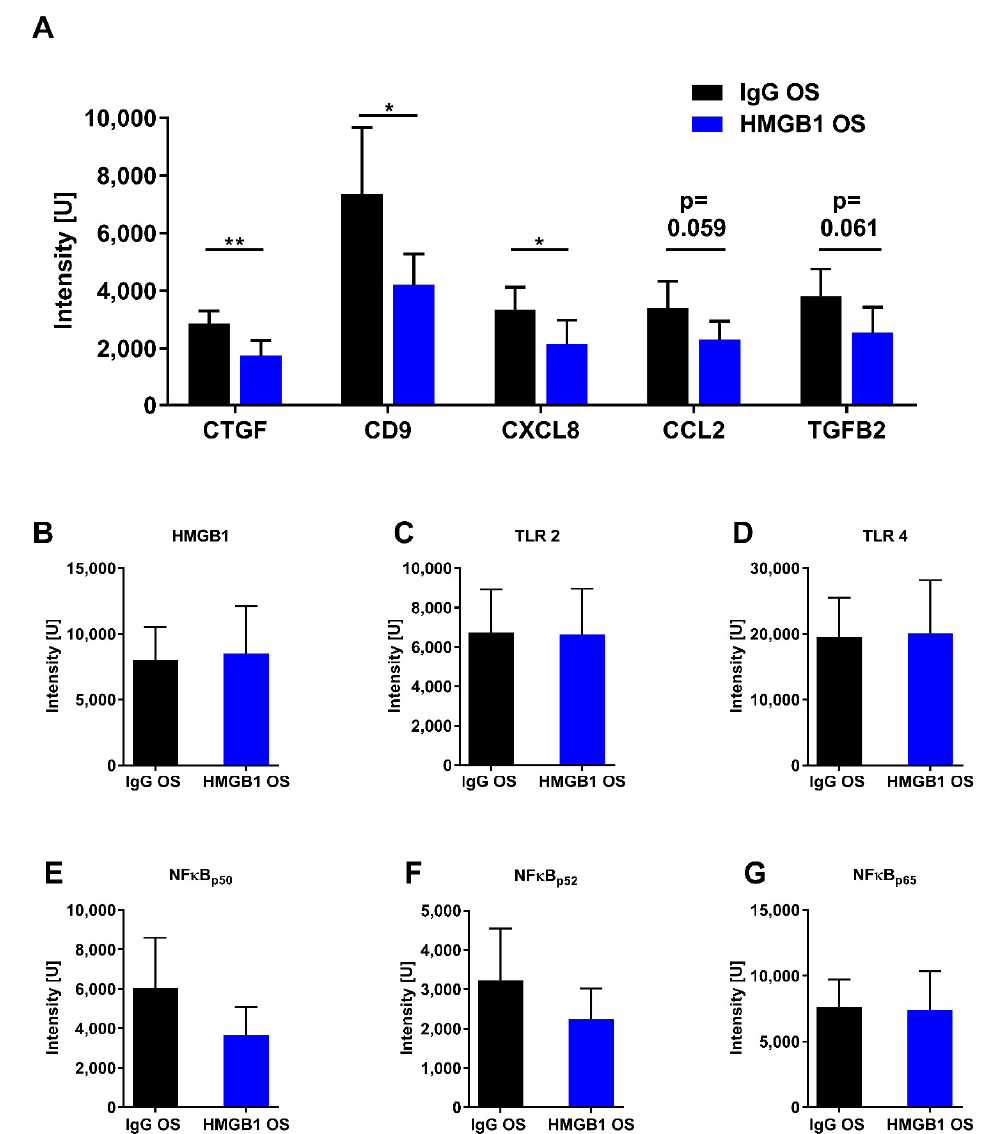
Figure 7. Expression pattern of selected retinal proteins analyzed by an antibody microarray. For the analysis, 10 µg of protein lysate was used. This was labeled, and a size exclusion chromatography column removed excess unbound dye and buffers unfavorable for the array incubation. The altered proteins with respective expressions in the elevated-IOP eyes were shown. ** p < 0.01, * p < 0.05, other p values as indicated, Student’s t -test ( A ). The protein expression of the high-mobility group box protein 1 (HMGB1) was examined in the IgG animals (OS, OD) and the antibody-treated HMGB1 animals (OS, OD) ( B – G ).